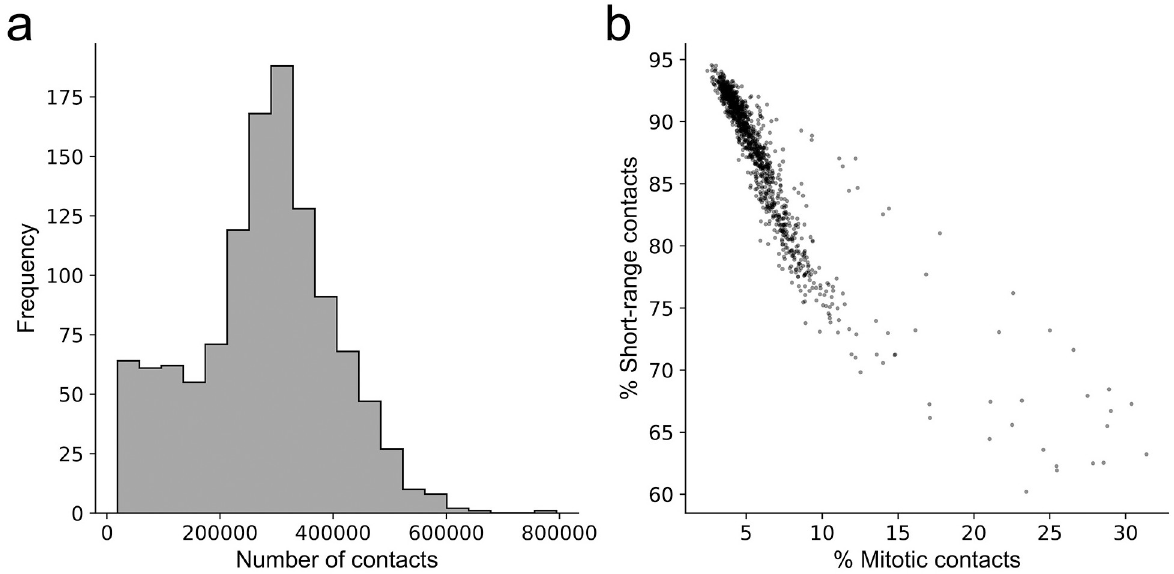
Fig 2. Summary plots for examining the quality of input scHi-C data. (a) A histogram of contact numbers in the individual cells. (b) A scatter plot showing the percentage of short-range contacts ( < 2 Mb) versus the percentage of contacts at the mitotic band (2 * 12 Mb) in individual cells.